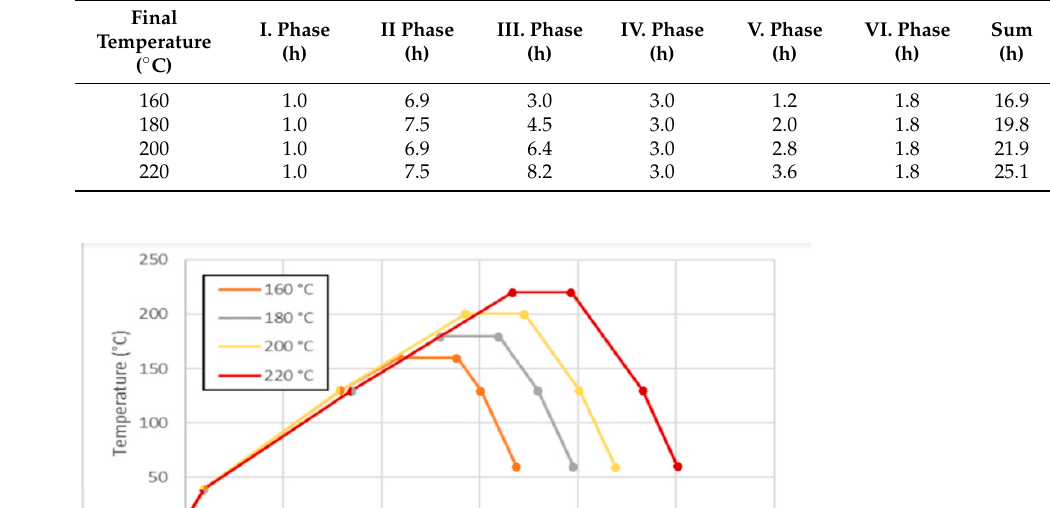
Table 1. Time intervals of the thermal modification of spruce [25].